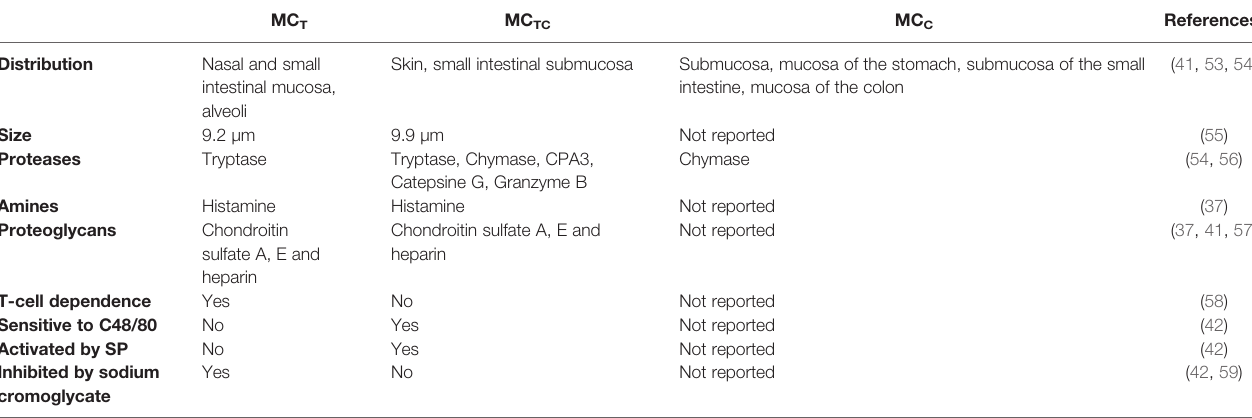
TABLE 2 | Main characteristics of MC types described in humans.